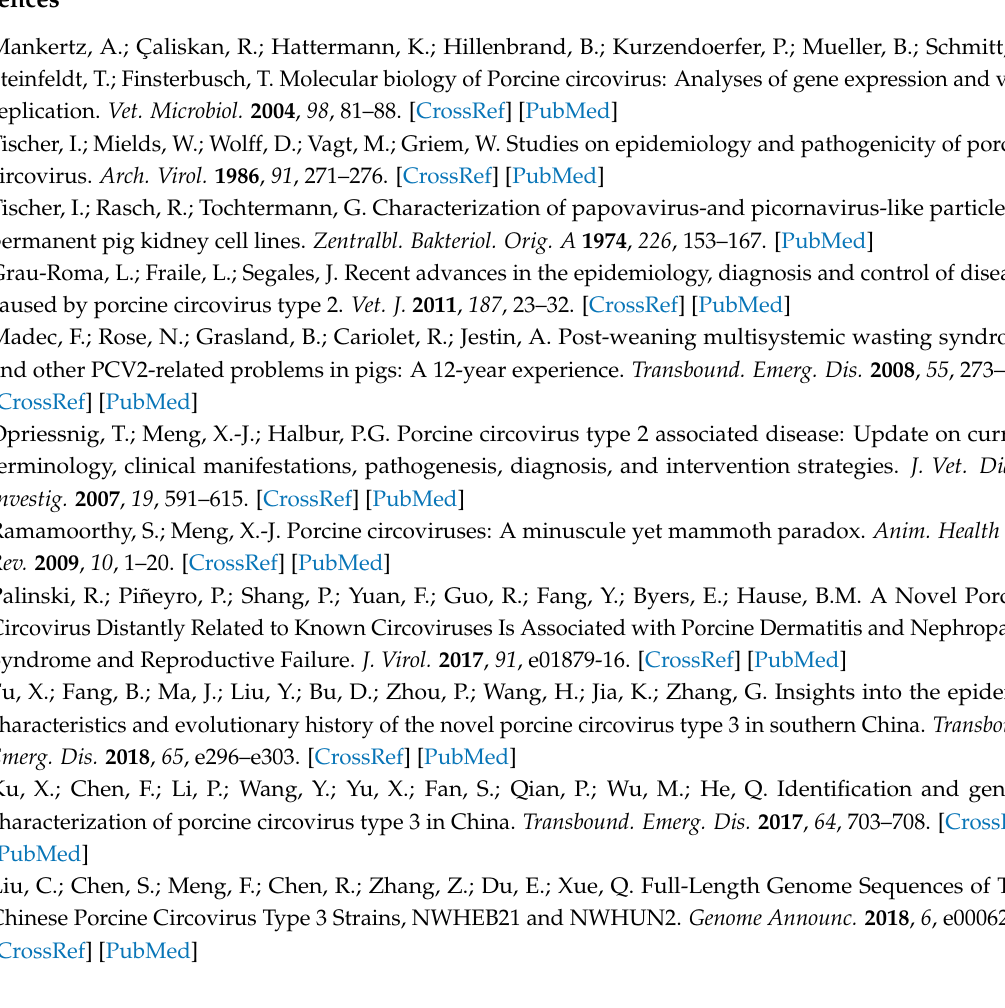
Table S1: Detailed information of 67 tissue samples collected from pigs between 2006 and 2007 from nine states of